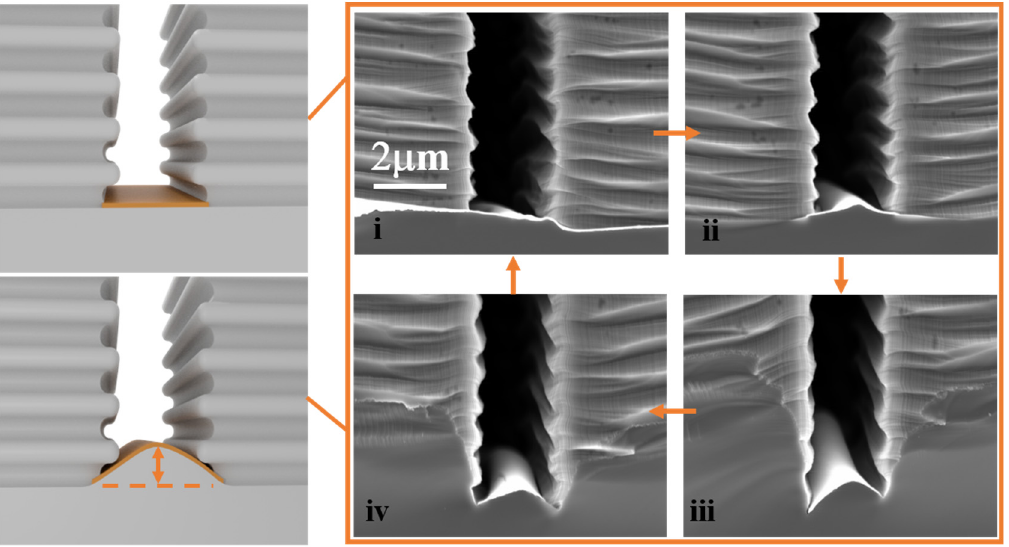
Figure 2. Mechanistic analysis of the formation process of sidewall roughness. ( i ) The metal layer maintains the same flatness. ( ii ) Small bending deformation of metal layer. ( iii ) The metal layer structure achieves the maximum bending degree. ( iv ) The metal layer gradually returns to flatness.